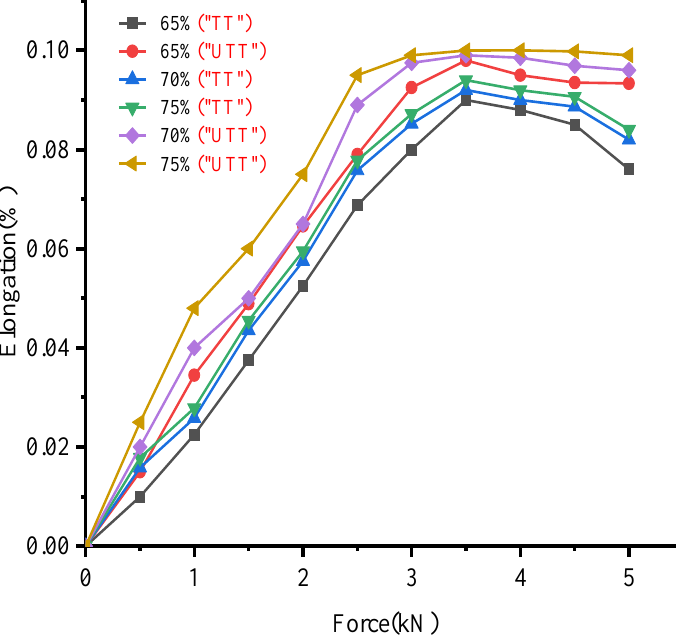
Figure 3. Tensile force-elongation diagram of treated and untreated CH composites. Here, 65% TT, 65% UTT, 70% UTT, 70% TT, 75% TT and 75% UTT represent 65% of treated CH, 65% of untreated CH, 70% of untreated CH, 70% of treated CH, 75% of untreated CH and 75% of treated CH in the composite mixtures, respectively.